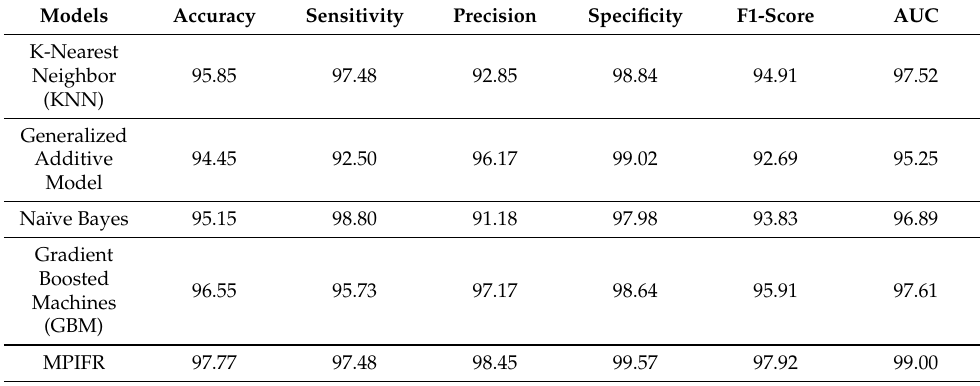
Table 6. Results of classifying the MPIFR with various machine learning (ML) classifiers.